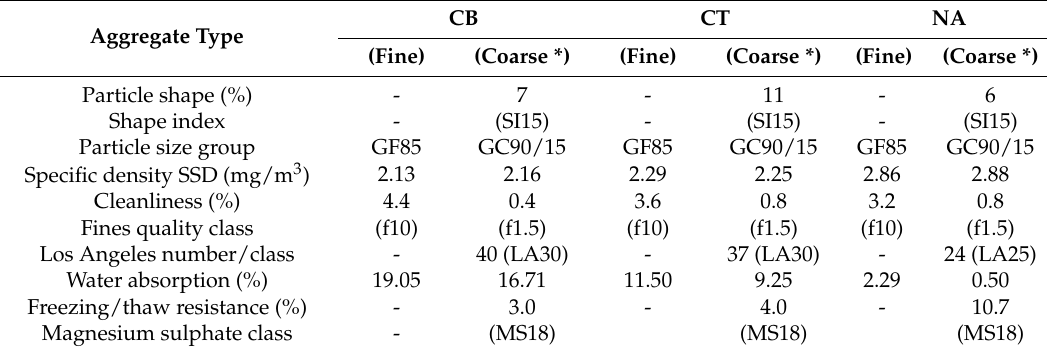
Table 1. Properties of CB, CT and NA determined according to [5].